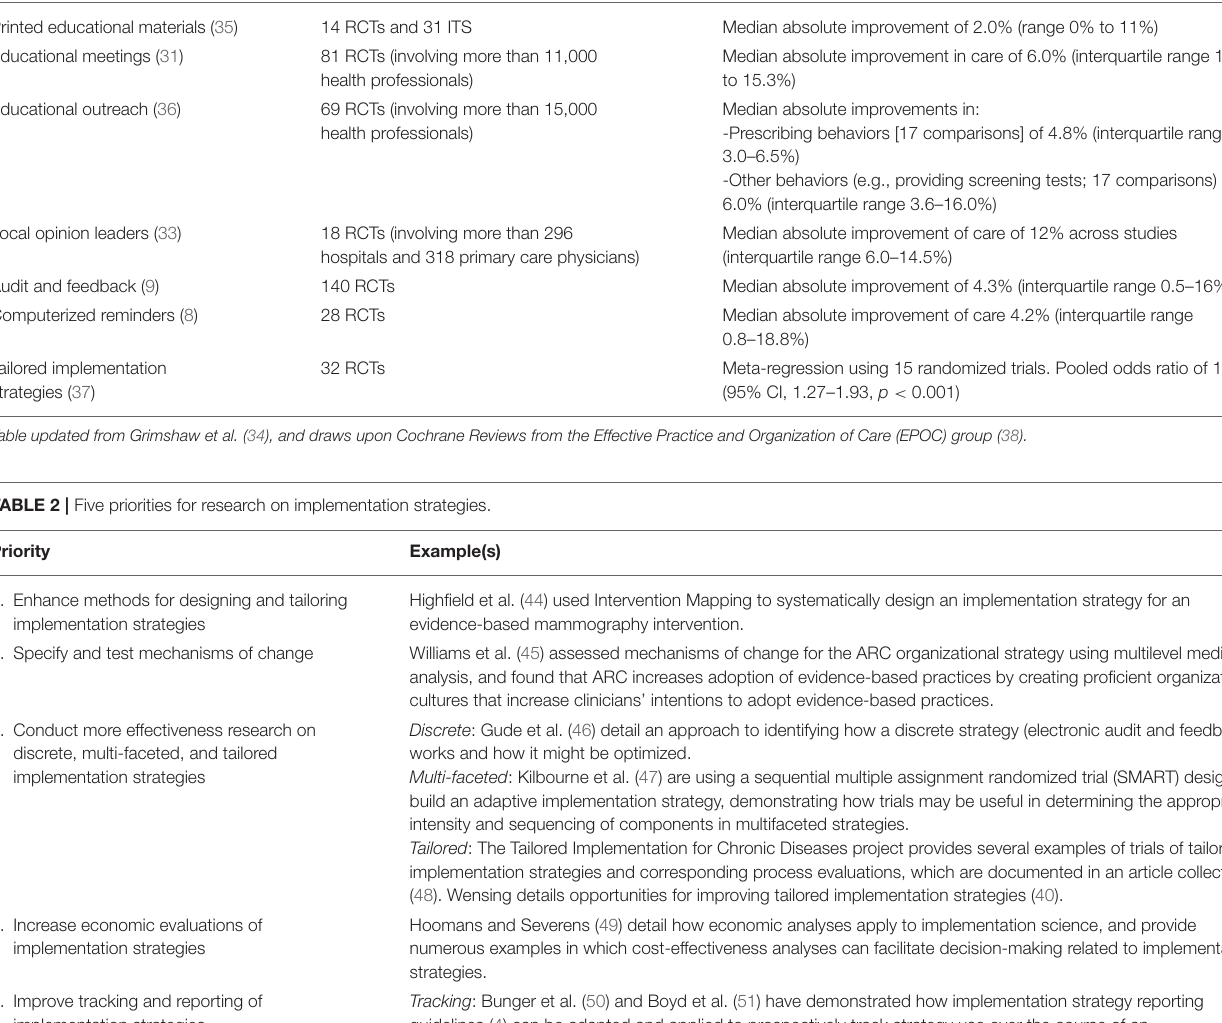
TABLE 1 | Evidence for common implementation strategies targeting professional behavior change.